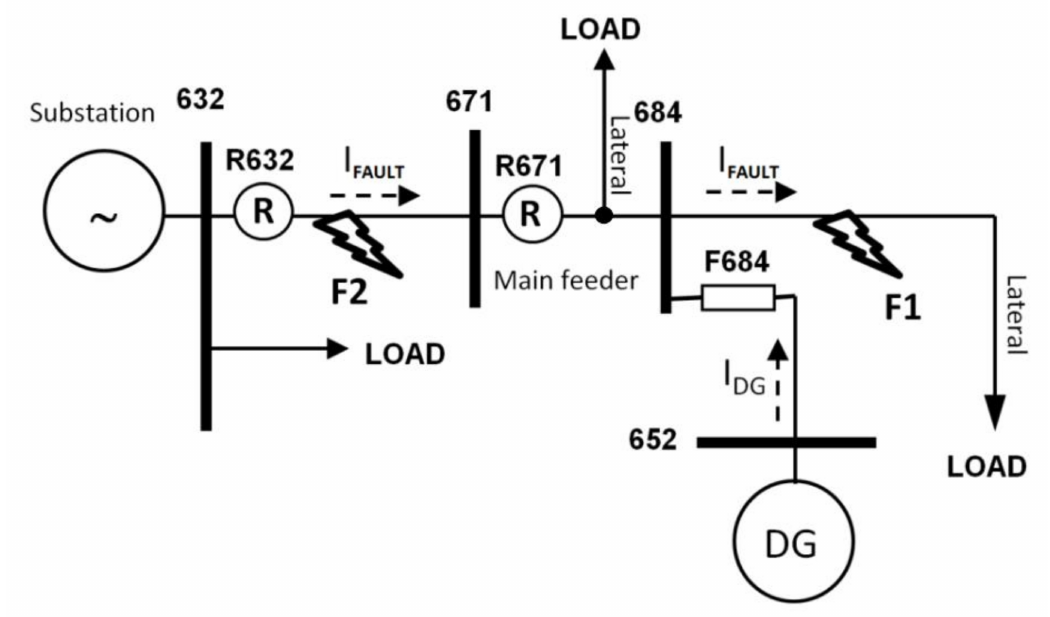
Figure 10. Protection Zone 3 electric circuit (see also Figure 2), in which short-circuits in points F1 and F2 are indicated.